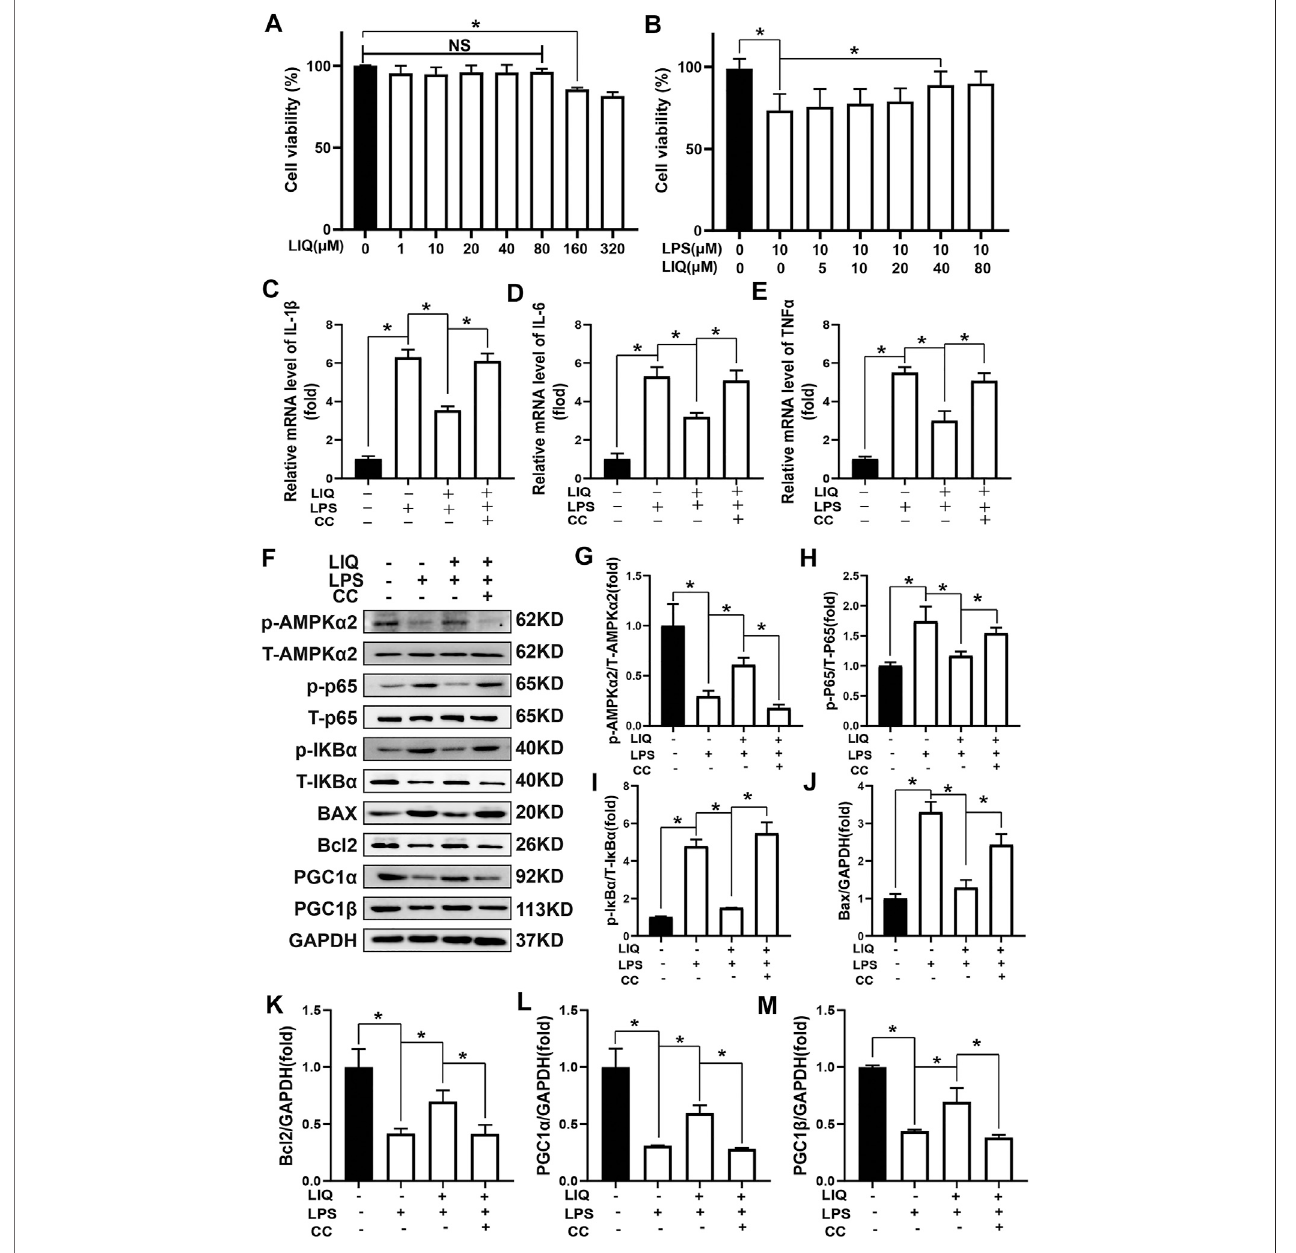
FIGURE 7 | LIQ treatment could not protect against LPS-induced cardiomyocyte injuries after inhibiting AMPK activity in vitro (A) CCK-8 kit was used to examine cell viability after treating different concentration of LIQ (0, 1, 10, 20, 40, 80, 160, 320 µM) for 12 h ( n (cid:2) 9), (B) CCK-8 was used to examine cell viability in different treatmentasindicatedinthepicture( n (cid:2) 9),NRCMswerepretreatedwithLIQfor2 handthenweretreatedwithLPS(1 μ g/ml)foranother 12 h,RT-PCR wasperformed to analyze mRNA expression of IL-1 β (C) , IL-6 (D) and TNF- α (E) , all of the mRNA expression were normalized to GAPDH before the relative quantitative analysis ( n (cid:2) 6). (F) representative western-blots of phosphorylated AMPK α 2 (p-AMPK α 2), total-AMPK α 2 (T-AMPK α 2), p-P65, T-P65, p-I κ B α , T-I κ B α , BAX, Bcl2, PGC1 α , PGC1 β and GAPDH ( n (cid:2) 6), relative quantitative analysis proteins expression of p-AMPK α 2/T-AMPK α 2 (G) , p-P65/T-P65 (H) , p-I κ B α /T-I κ B α (I) , BAX/GAPDH (J) , Bcl2/ GAPDH (K) , PGC1 α /GAPDH (L) and PGC1 β /GAPDH (M) ( n (cid:2) 6), all proteins were normalized to GAPDH before the quantitative analysis. The cell experiment was repeated 3 times independently. * p < 0.05 compared with the indicated group, the data were expressed as the Mean ± SEM and were compared by one-way ANOVA with Tukey post hoc